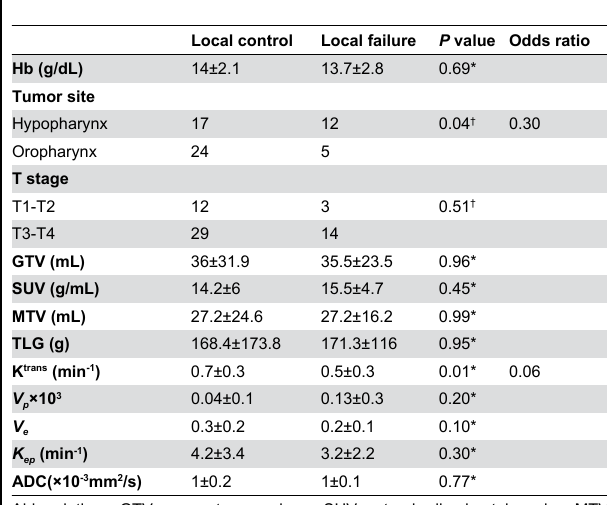
Table 3. Comparison of variables between the local control and local failure groups.